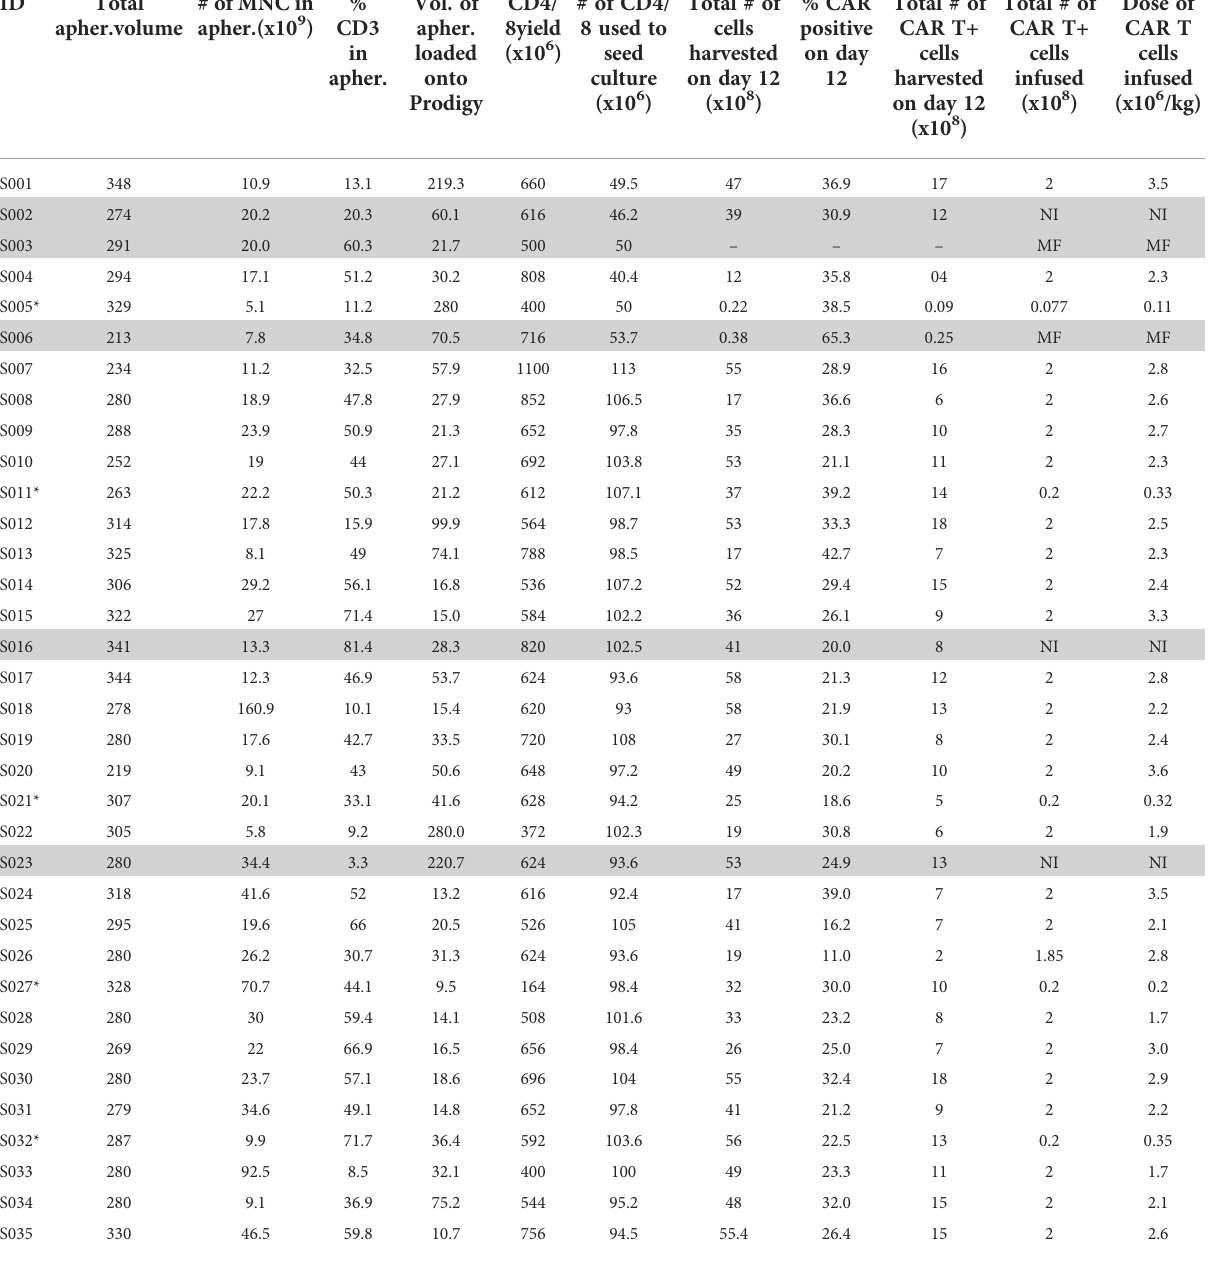
TABLE 2 Apheresis material and CAR-T cell product characteristics. ID Total # of MNC in apher.volume apher.(x10 9